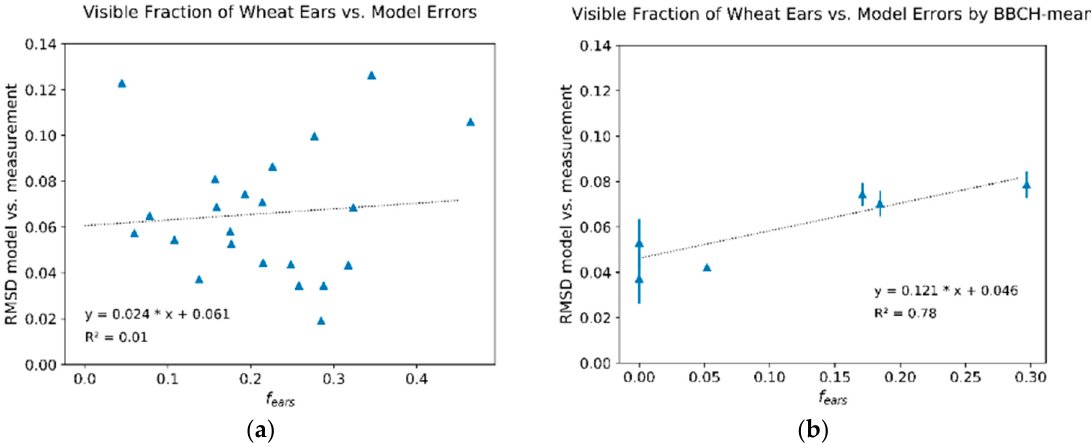
Figure 13. Dependency between the fraction of visible ears (f ears ) and the RMSD of spectral measurement vs. PROSAIL output for all winter wheat data ( a ) and aggregated into phenological macro stages ( b ). Standard deviations of the BBCH-aggregation in b are symbolized by vertical error bars.